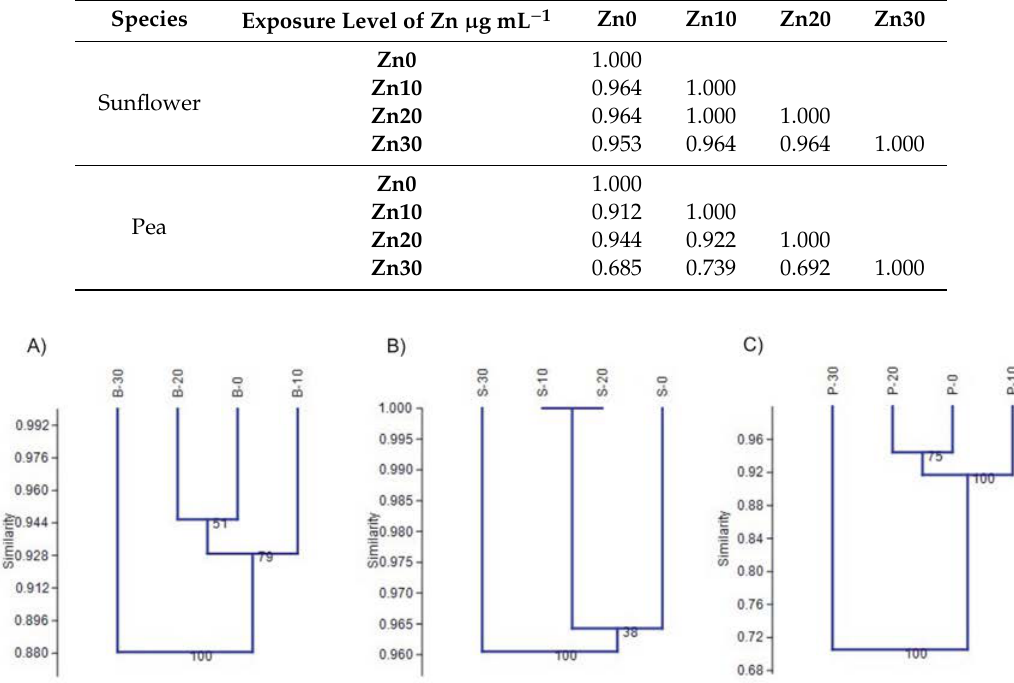
Figure 1. Dendrogram of the studied broccoli ( A ), sunflower ( B ) and pea ( C ) samples, constructed with the Jaccard similarity coefficient using UPGMA cluster analysis based on the RAPD data (cophenetic correlation for broccoli r = 0.855, for sunflower r = 0.991, for pea r = 9883). Sprouts of all species were obtained via enrichment of seeds with Zn0, Zn10, Zn20 and Zn30.